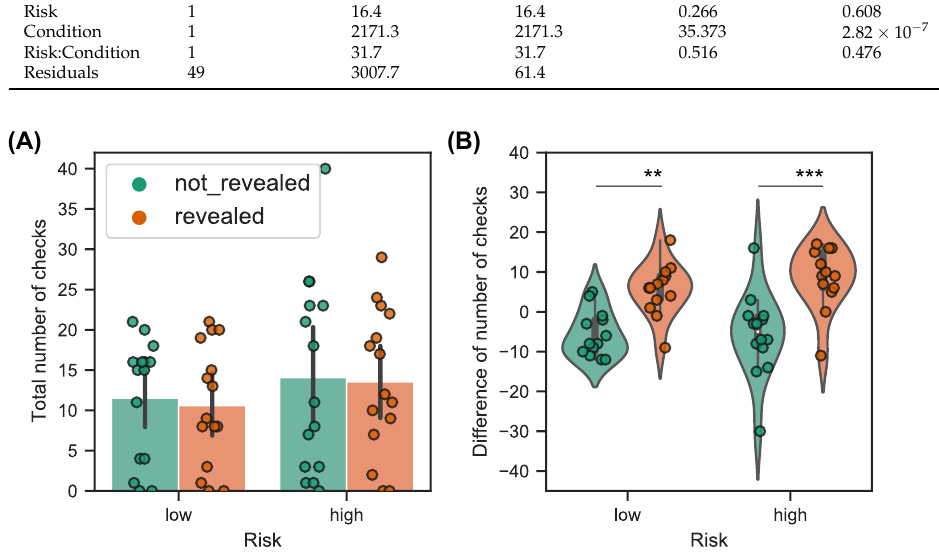
Figure 4. The number of trials where participants chose to check the model’s prediction. ( A ) The total number of checks; ( B ) the difference between the checks of the objects drawn from the low-accuracy set and the ones from the high-accuracy set. A positive value corresponds to a larger amount of checks for the objects of low accuracy. The data are visualized using bar plots and violin plots with superimposed individual data for each participant. In violin plots, the thick gray bar in the center represents the interquartile range. The thin gray line represents the rest of the distribution except the outliers. The error bars in the bar plots indicate confidence intervals of 95% computed using bootstrapping. The indicators of significant differences obtained from the ANOVA analysis are **: p < 0.005, ***: p < 0.001. Not significant differences are not